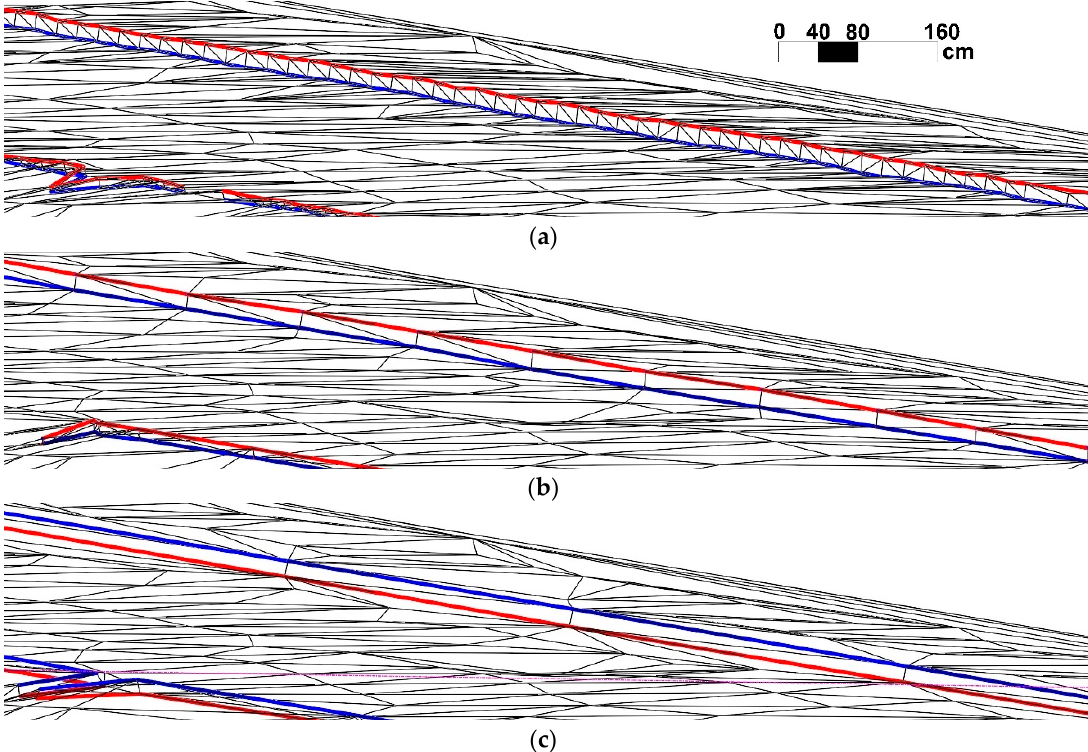
Figure 18. Triangulation evaluation: ( a ) proposed method, ( b ) manual method, and ( c ) field survey. Table 2. Manual, field, and proposed methods